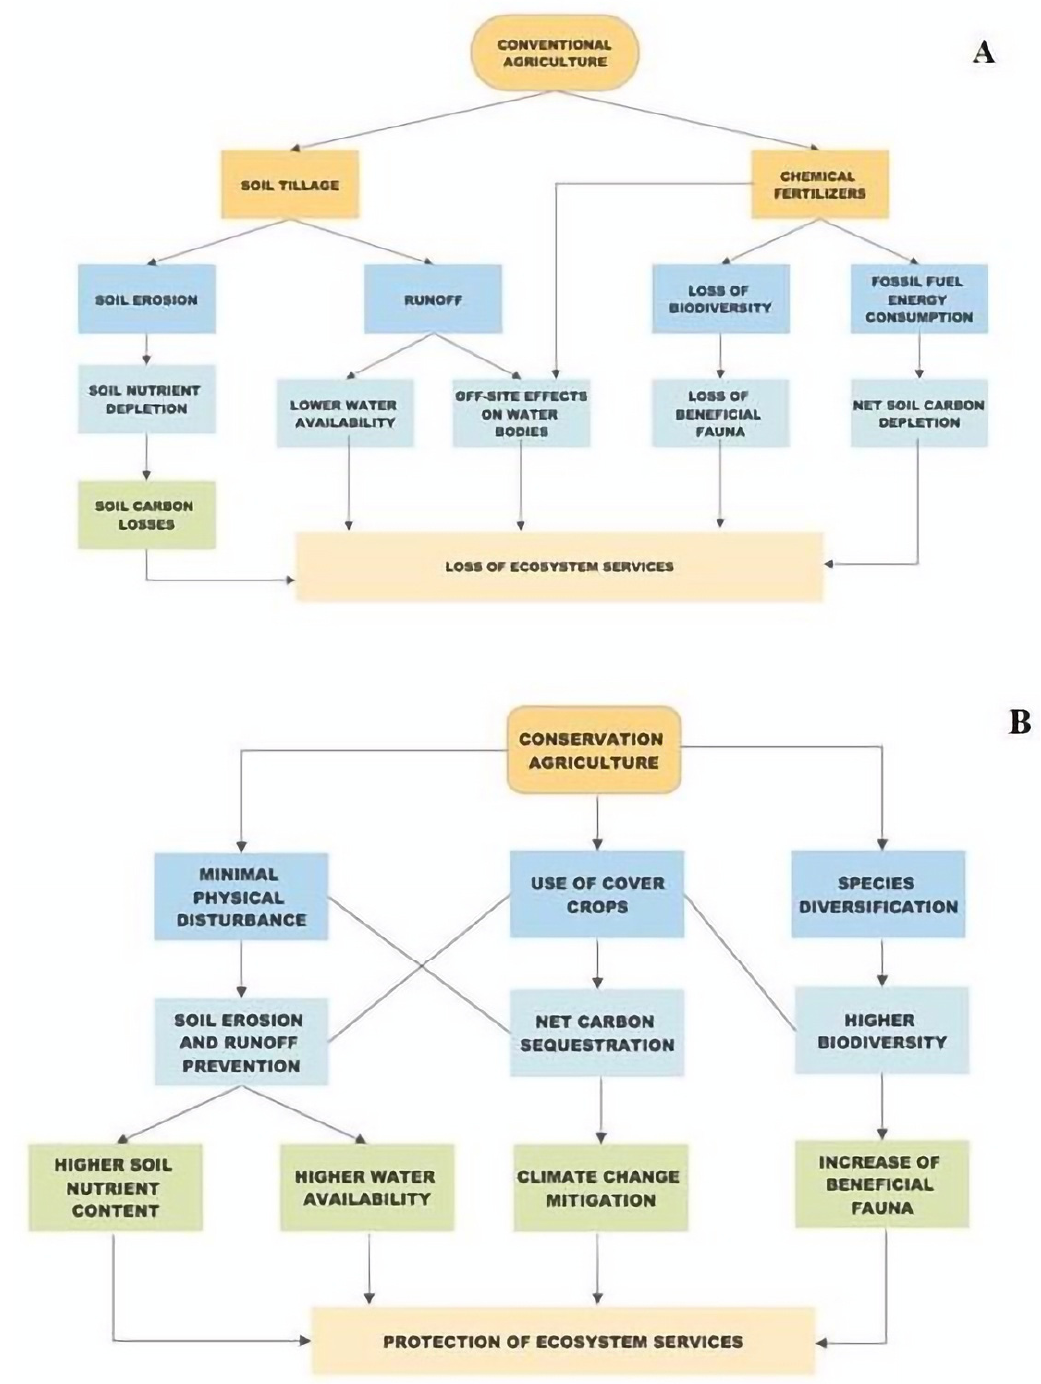
Figure 2. Environmental impacts of conventional agriculture ( A ) and the benefits of conservation agriculture ( B ) on soils.